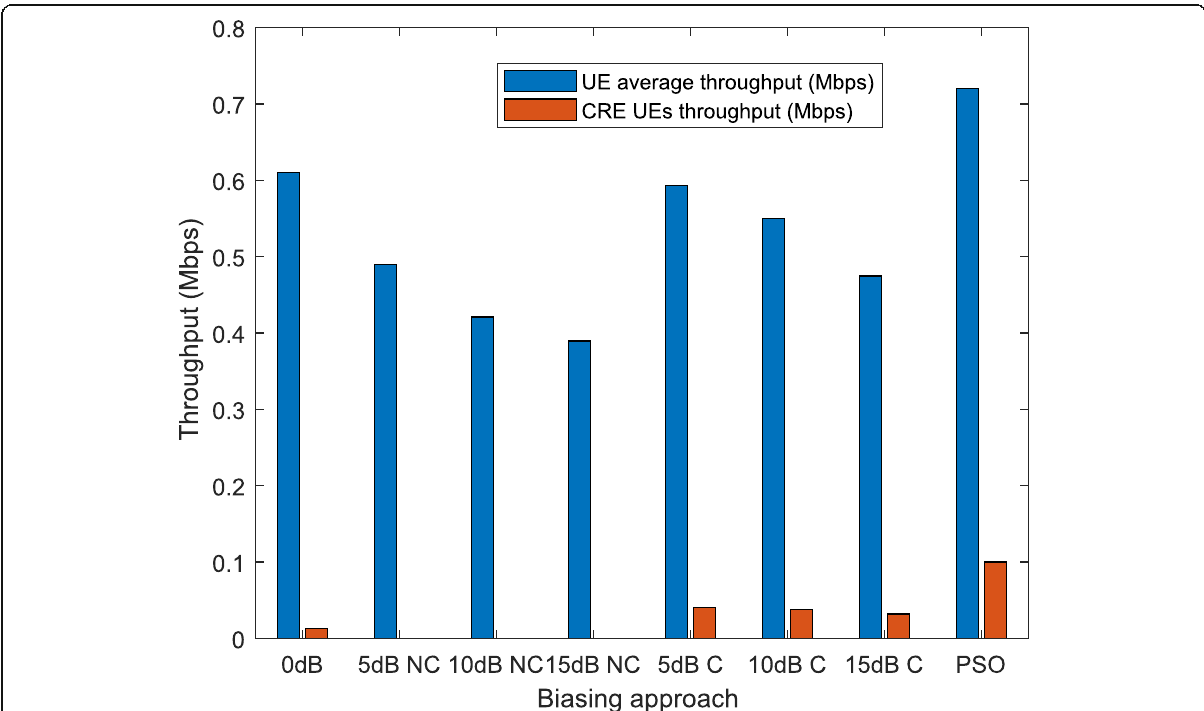
Fig. 7 Average UE throughput and CRE throughput for different biasing approaches. NC and C refers to no CoMP and CoMP, respectively. In this figure, the average user throughput and the throughput of cell range expansion for biased user association with and without CoMP are shown. From the figure, per base station biasing using particle swarm optimisation outperforms the per-tier biasing with and with no